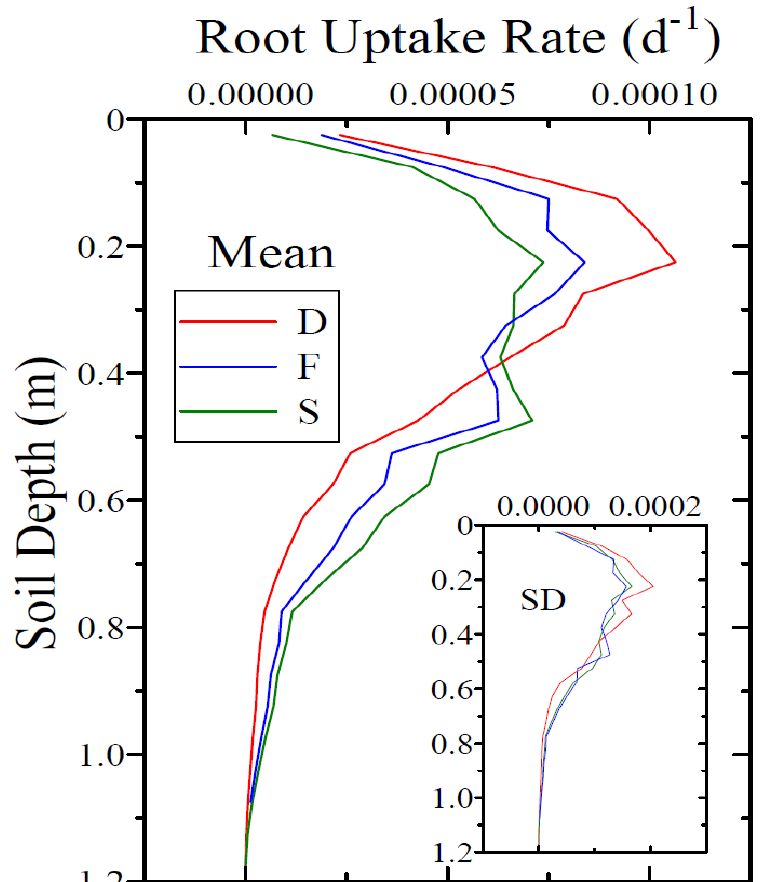
Figure 1. Profiles of the horizontally averaged root’s water uptake rate for the three di ff erent irrigation scenarios (D, Ccl = 50 ppm, F, Ccl = 300 ppm, and S, Ccl = 640 ppm); in all cases, C NH4 = 10 ppm and C NO3 = 70 ppm. Results are depicted for t = 455 d (ninety days after the start of the irrigation season of the second year). D, desalinated; F, fresh; S, saline.